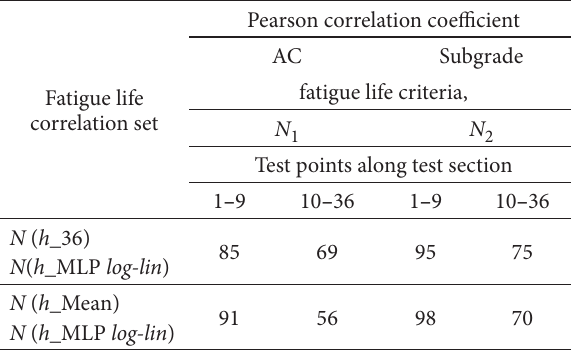
Fatigue life correlation